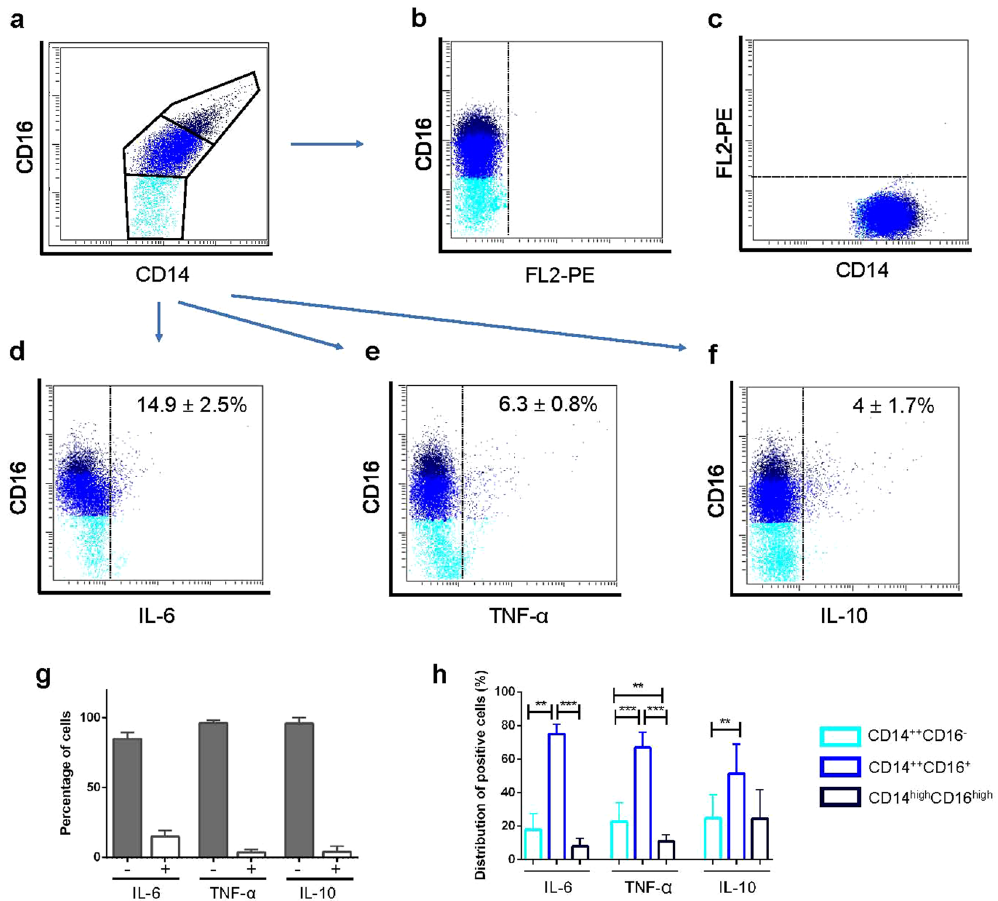
Figure 6. Flow cytometry determination of IL-6, TNF- α and IL-10 intracellular expression. Representative FACS dot-plots showing CD14/CD16 gating ( a ), Fluorescence Minus One (FMO) controls of PE channel (FL2) in which cells were stained with CD16-PE-Cy5 ( b ) and CD14-FITC ( c ), and intracellular expression of cytokines IL-6 ( d ), TNF- α ( e ) and IL-10 ( f ) related to CD16 cell membrane expression are displayed. Bars showing percentages of cytokine-negative (grey bars) and cytokine-positive (white bars) peritoneal monocyte/macrophages are displayed as mean ± SEM ( g ). Empty bars with coloured edges represent distribution of cytokine-positive cells into the three different CD14/CD16 subsets as mean ± SEM (%) ( h ). Mann-Whitney U test for the percentages of cytokine-positive cells among the three CD14/CD16 subsets: ** p < 0.01, *** p < 0.001 ( e ). Light blue: CD14 ++ CD16 − subset; bright blue: CD14 ++ CD16 + subset; dark blue: CD14 high CD16 high